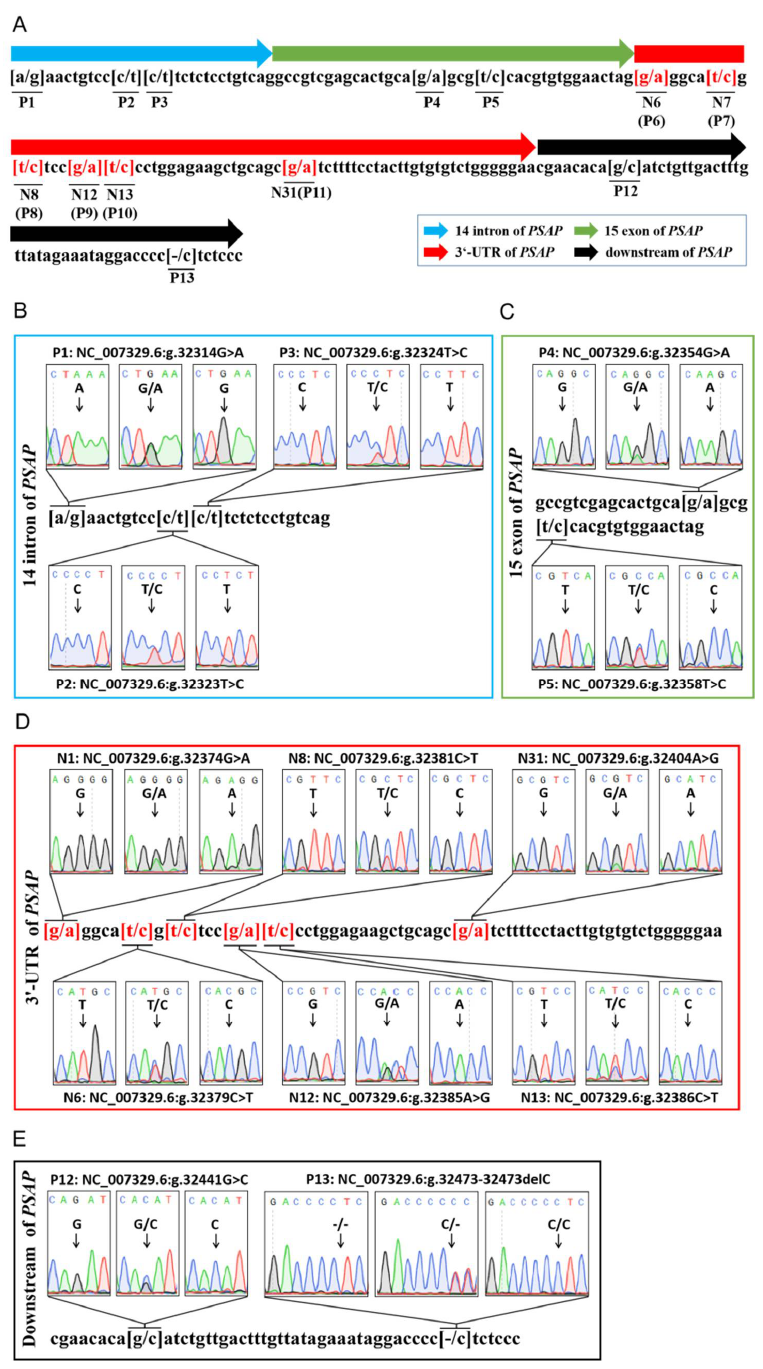
Figure 1. Sequencing of variants in bovine PSAP . ( A ) The genetic mapping of bovine PSAP by sequencing; ( B ) three single-nucleotide polymorphisms (SNPs) in the 14th intron of bovine PSAP ; ( C ) two SNPs in the 15th exon of bovine PSAP ; ( D ) five SNPs in bovine PSAP 3’ UTR; ( E ) two vari- ants in the downstream region of bovine PSAP . P: the number variants in the fragment of PSAP ; N: the number of bases in PSAP 3’ UTR.